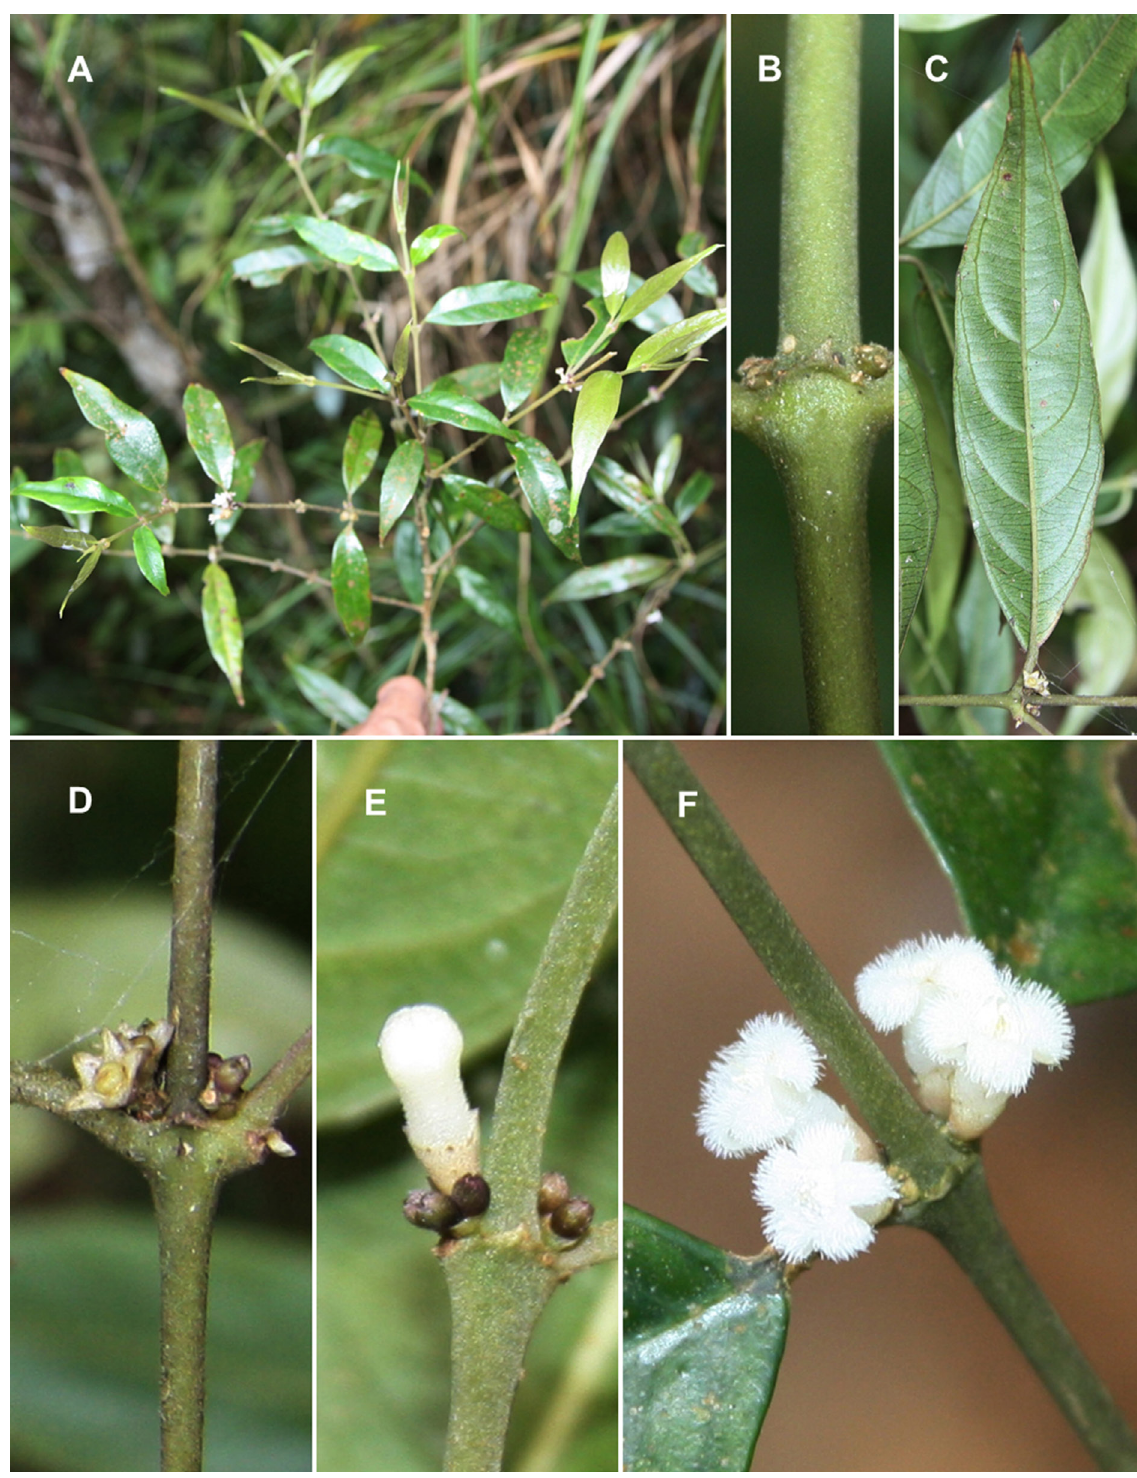
Fig. 6. Lasianthus caeruleus Pitard. A . Flowering branchs. B . Stipule. C . Abaxial leaf surfaces. D–E . Close-up of calyces, flower buds and young fruits. F . Close-up of inflorescences and flowers. Photos by Van-Son Dang on 26 Jul.